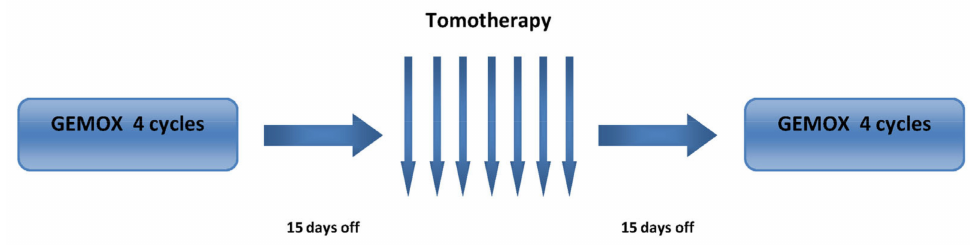
Figure 3. Treatment strategy. GEMOX: Gemcitabine (GEM) 1000 mg / m 2 on day 1, Oxaliplatin (OX) 100 mg / m 2 on day 2, every two weeks. Tomotherapy: 35 Gy in 7 fractions in 9 consecutive days, one session per day excluding Saturday and